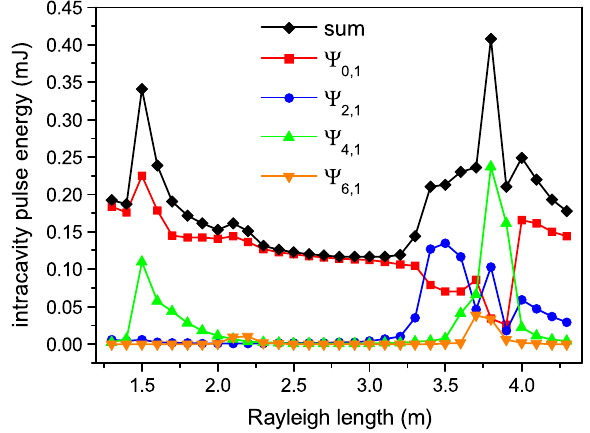
FIG. 5. The same as in Fig. 4 but when δ L ¼ − 28